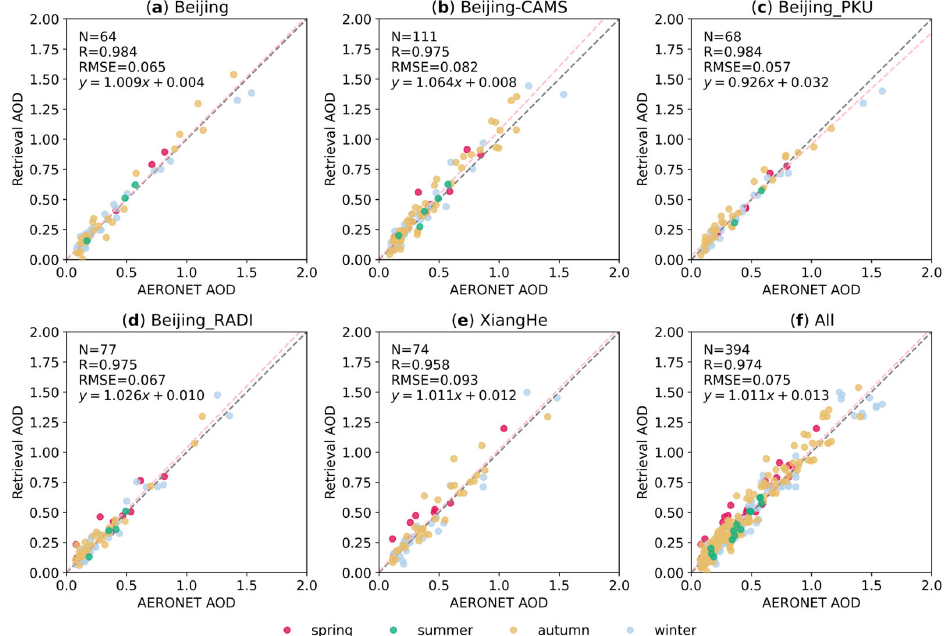
Figure 3. Comparisons of the AOD retrievals with AERONET in five sites ( a – e ), and comparisons of the AOD retrievals with AERONET using all five sites ( f ) (different color points represent different seasons).